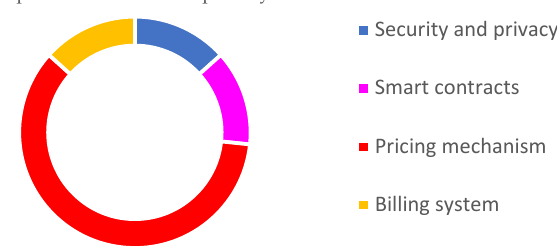
Figure 8. Research situation of blockchain in electricity bill settlement.